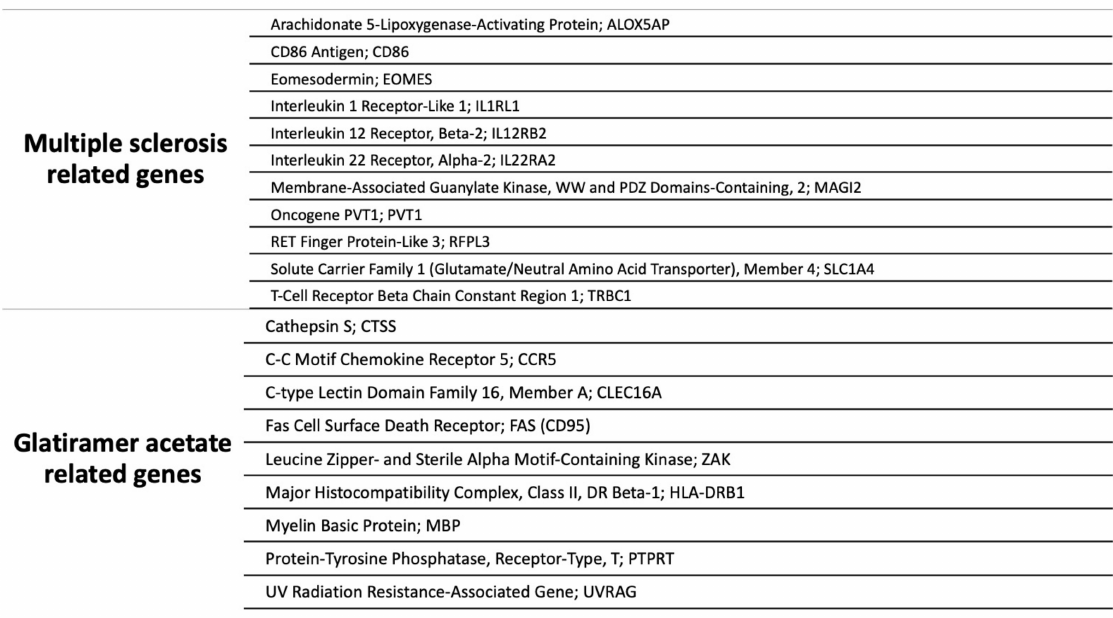
Figure 2. Genes involved in pharmacogenetics of